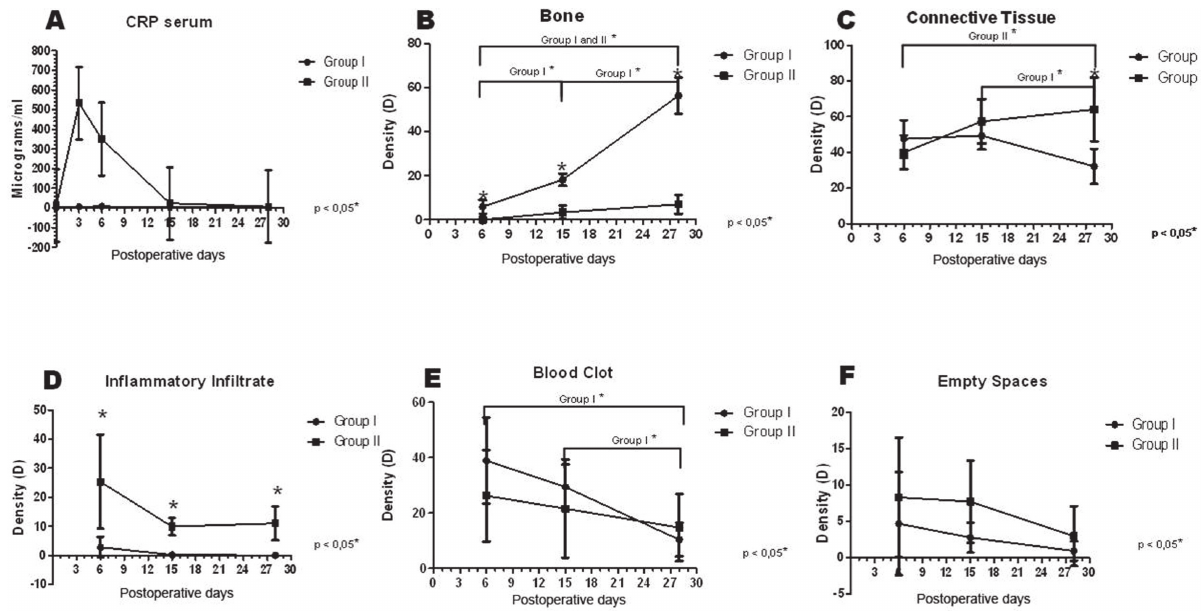
Figure 2- Increased serum CRP and delayed alveolar healing in experimental alveolitis rats. (A) CRP serum level results. (B to F) Histometric results: bone, connective tissue, inflammatory infiltrate, blood clot and empty space density, presented as means and standard deviations by group, in each period. Data were analyzed by groups using Student’s t test or Mann- Whitney Rank Sum Test and by periods using one-way ANOVA or Kruskal-Wallis test and Tukey’s or Dunn’s test for multiple comparisons.